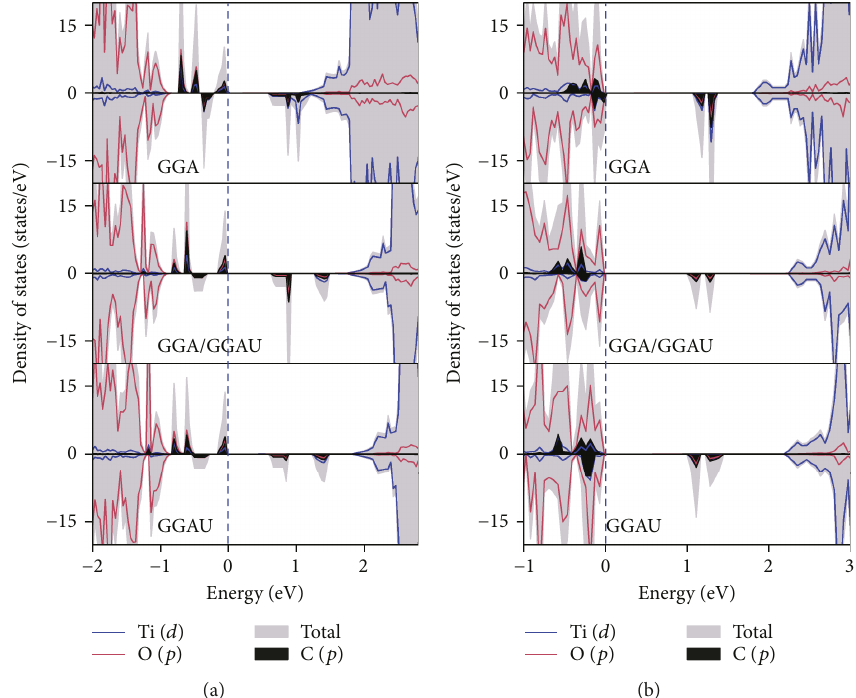
Figure 2: The total and partial density of states of the three relaxation methodologies for C-doped anatase TiO (b) The TiO (101) surface. The Fermi level corresponds to the zero 2